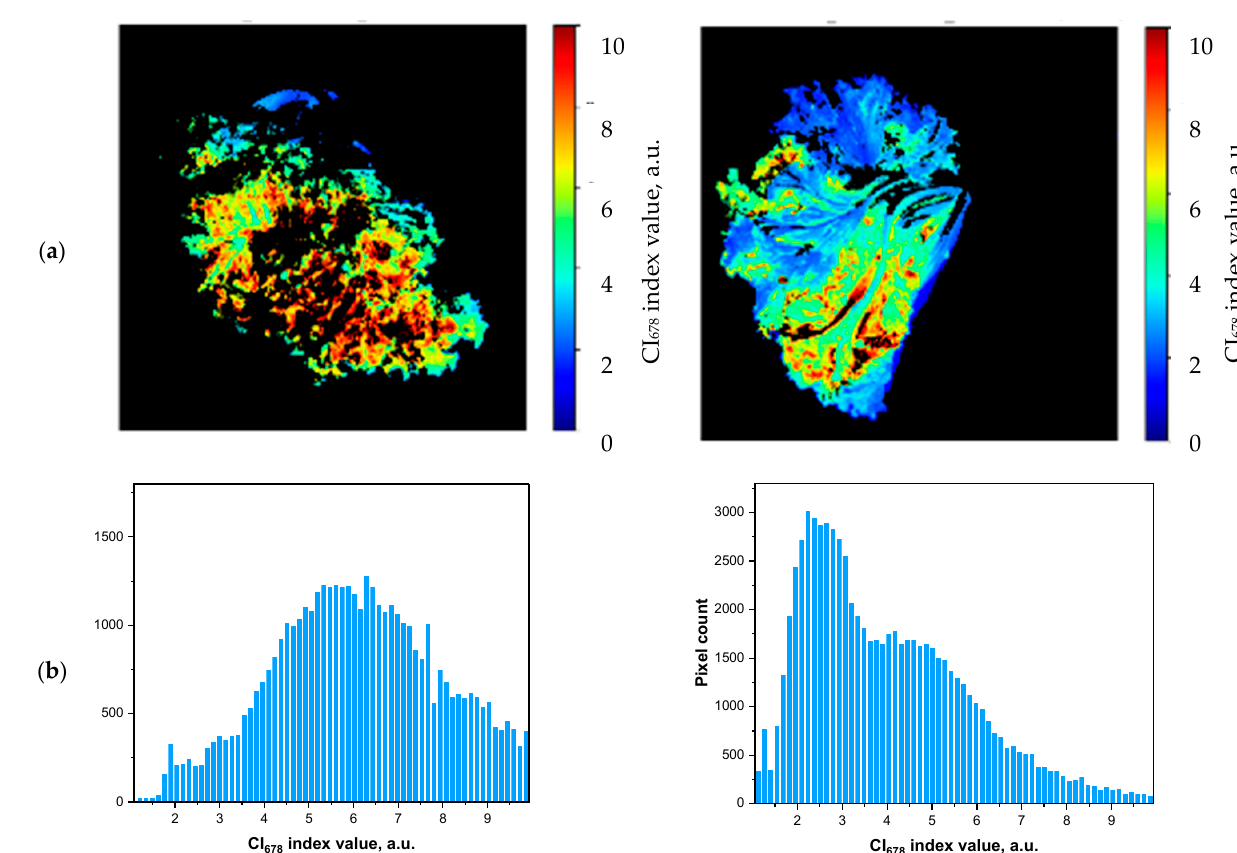
Figure 6. Representative changes in ( a ) leaf area exhibiting different values of CI 678 index (color-coded) indicative of Chl content and ( b ) the corresponding distribution of the pixel values of the color-coded images in the stored non-sealed fresh-cut lettuce leaves. The complete dataset presented in Figure S2 of the Appendix. For details, see Materials and Methods.